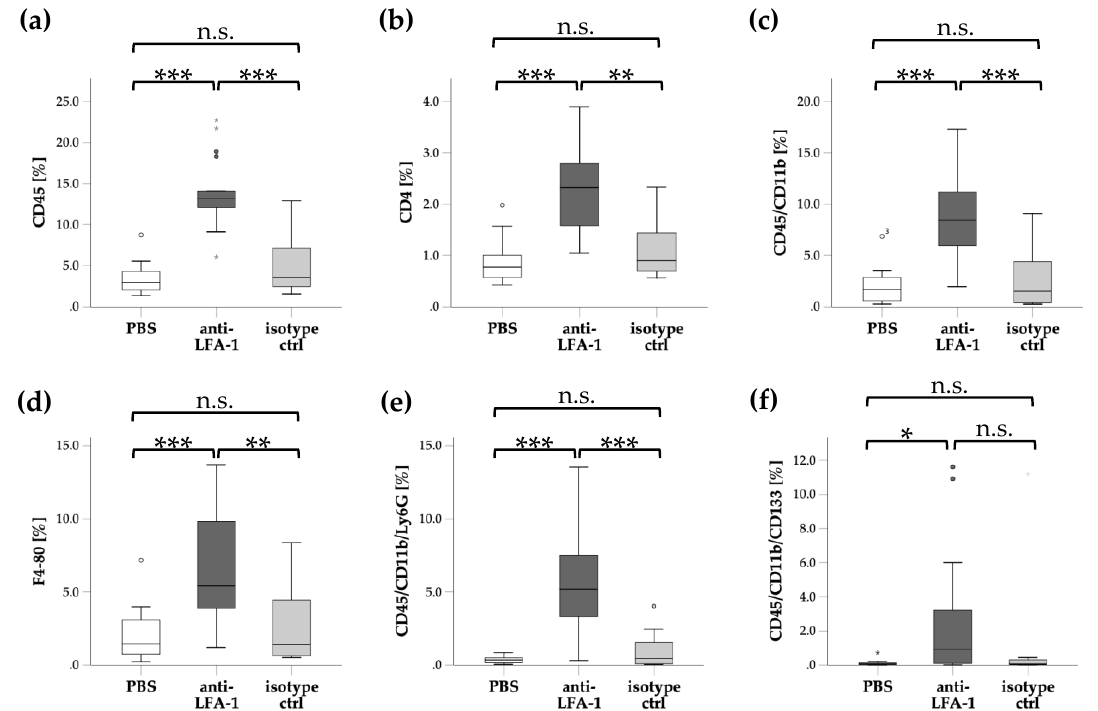
Figure 2. Infiltration of di ff erent leukocyte subsets is enhanced by blocking LFA-1: Flow cytometric analysis of leukocyte subpopulations in the inflamed cardiac tissue on day 21 after induction of EAM. Diagrams display the percentage of leukocytes ( a , CD45) and leukocyte subpopulations ( b , CD4; c , CD45 / CD11b; d , F4-80; e , CD45 / CD11b / Ly6G; f , CD45 / CD11b / CD133) of all cells after blocking LFA-1 (anti-LFA-1) compared with the matching isotype control antibody (isotype ctrl) or PBS. n = 18 for PBS, n = 17 for anti-LFA-1 and isotype ctrl. * p < 0.05; ** p < 0.01; *** p < 0.001; n.s., not significant. Kruskal Wallis test followed by Dunn-Bonferroni post hoc test. Data are presented as median with interquartile range, whiskers indicate 95% confidence